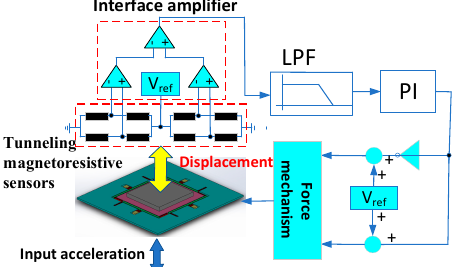
Figure 8. The scheme of measurement and control circuit.